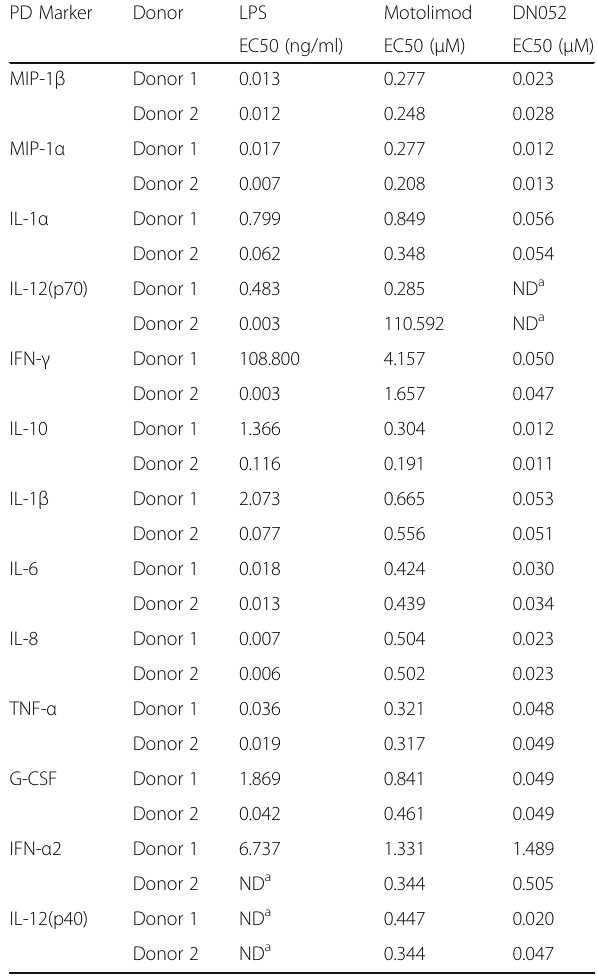
Table 3 DN052 induced cytokines in ex vivo human PMBCs PD